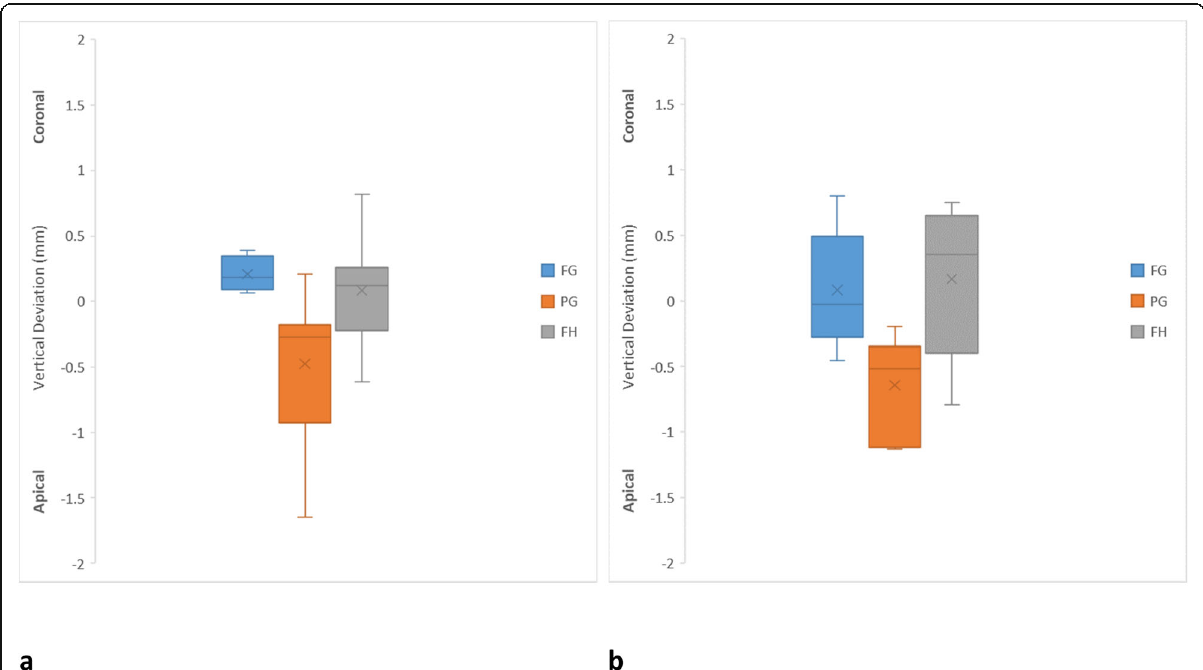
Fig. 3 Box plot diagrams illustrating the distribution of vertical deviation of each protocol. a Anterior implants. b Posterior implants